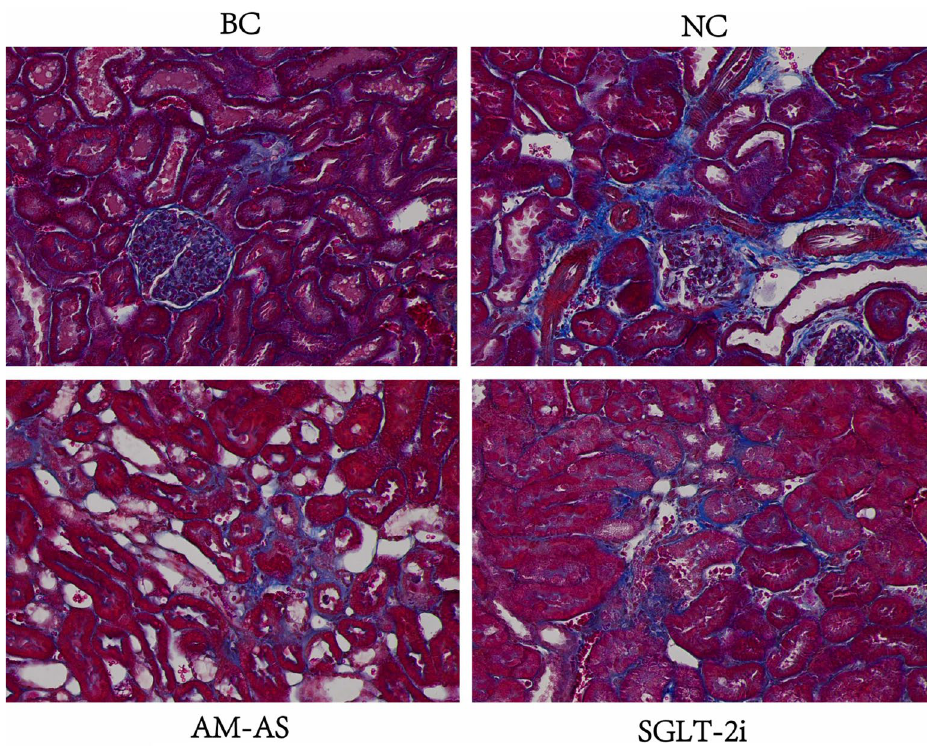
Figure 11. Renal tissue cells of rats (Masson ×